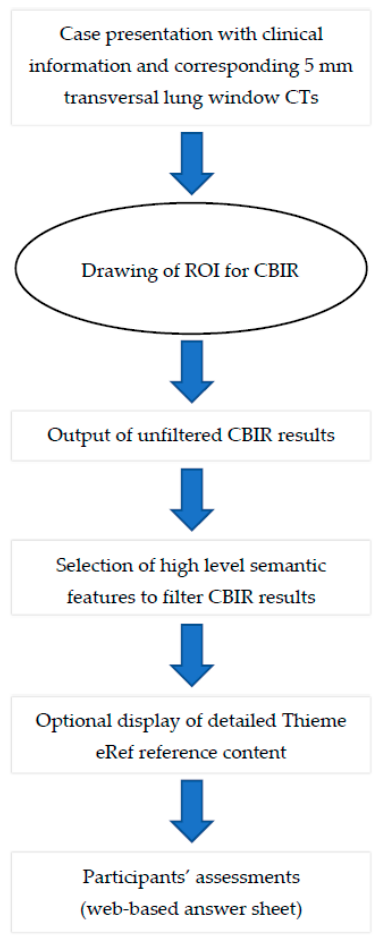
Figure 2. Workflow for each case presented to the participants.